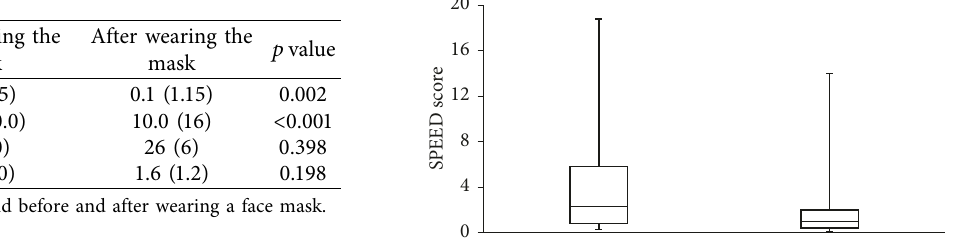
Table 1: The median (IQR) for the SPEED, NITBUT, PRT, and TF scores.